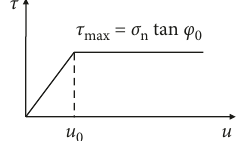
Figure 6: Coulomb friction law.